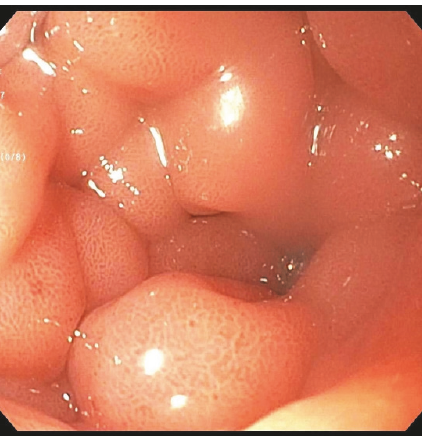
Figure 1: Enlarged prepyloric folds with luminal narrowing.